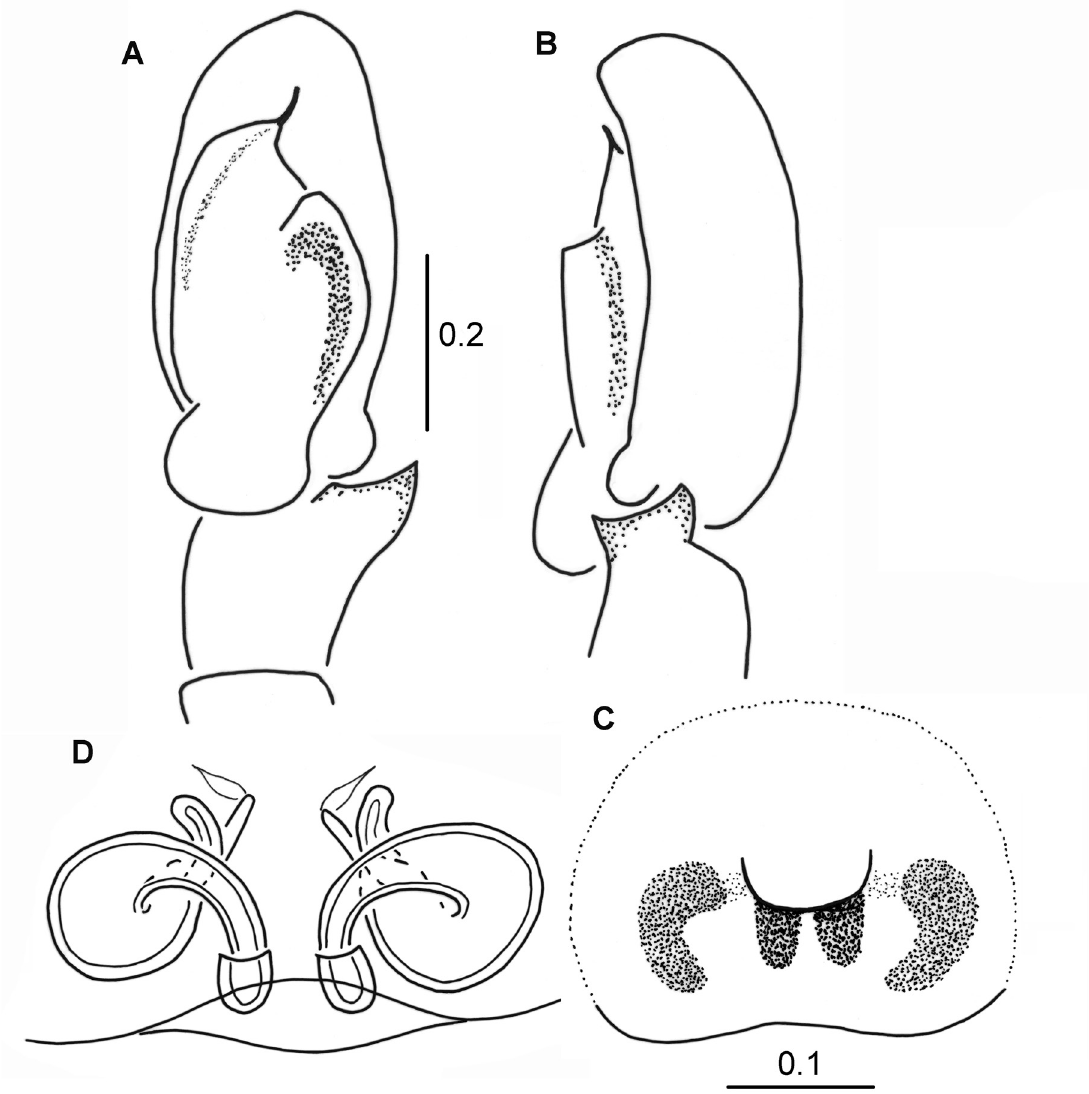
Fig. 28. Icius bandama sp. nov. A–B . Holotype, ♂ (MNHN). C–D . Paratype, ♀ (MNHN). A . Palpal organ, ventral view. B . Palpal organ, lateral view. C . Epigyne. D . Internal structure of